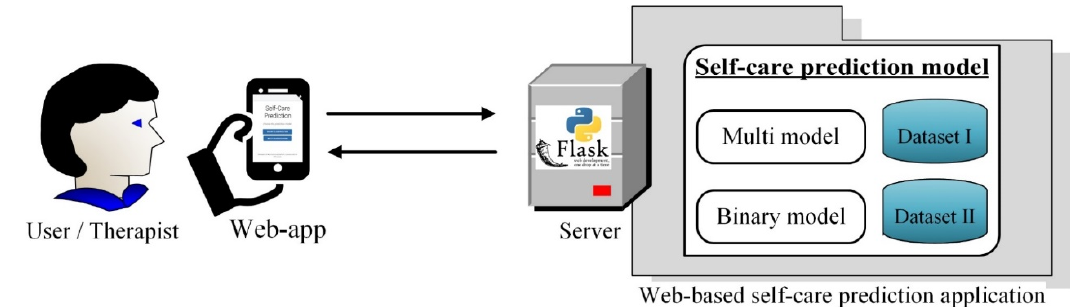
Figure 6. Self-care predication architecture framework.